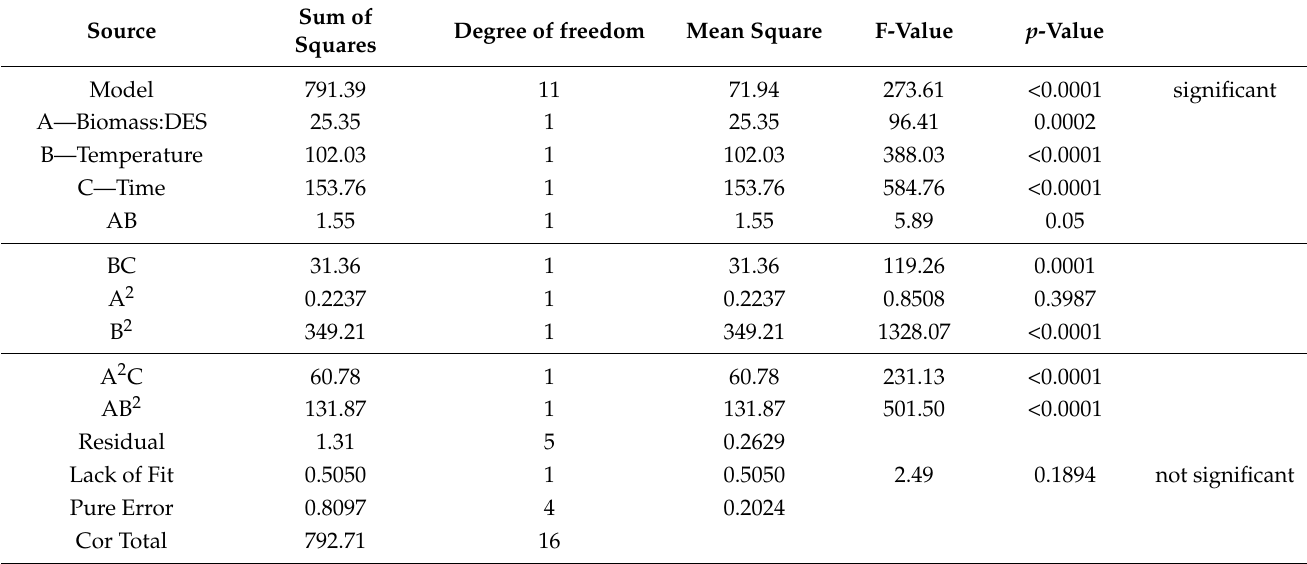
Table 3. ANOVA for the BBD-RSM optimization of DES